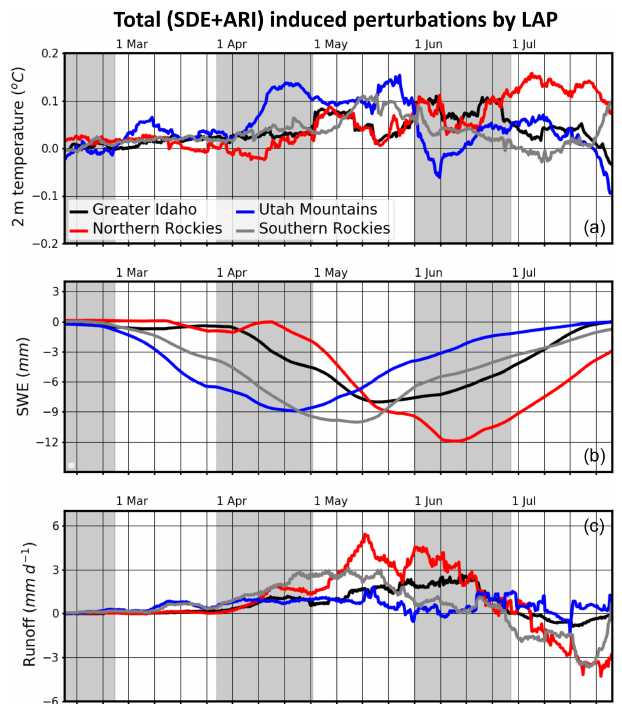
Figure 12. Total (SDE + ARI) region-specific perturbations to (a) 2m temperature, (b) SWE, and (c) runoff induced by